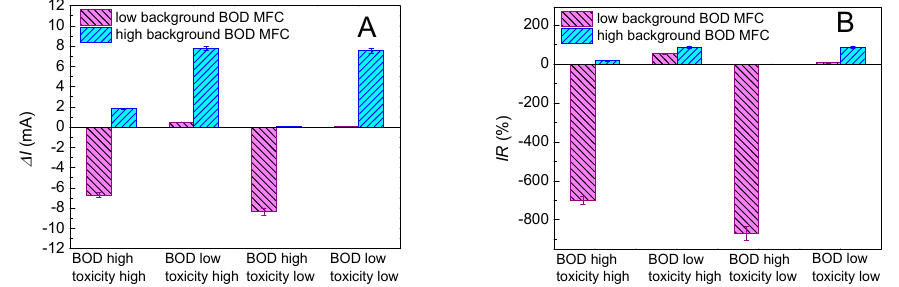
Figure 4. Response chart generated from MFC sensors run with high and low background concentrations of organic matter, respectively. Four types of combined shock caused by BOD and toxicity can be qualitatively distinguished using the response chart based on the Δ I ( A ) and IR ( B ).